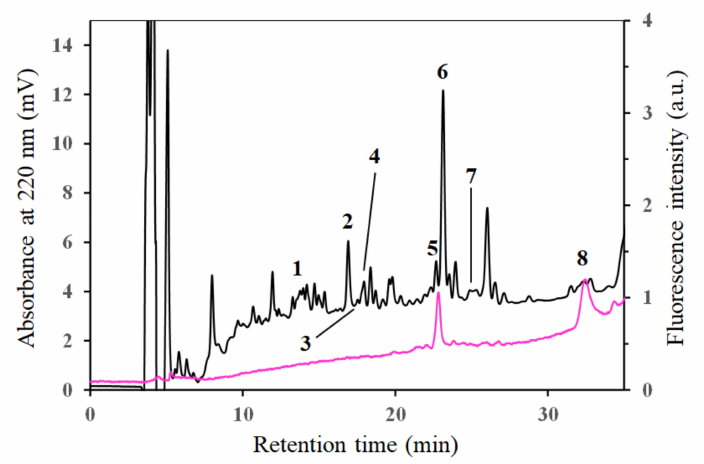
Figure 7. RP-HPLC analysis of the DanE modified Csin fragments after tryptic digestion. The profiles were monitored via UV detection (220 nm, black) and fluorescent detection ( λ ex 329 nm and λ em 512 nm, magenta). The obtained fragments (peaks 1–8) were collected and subjected to ESI-TOFMS analysis.